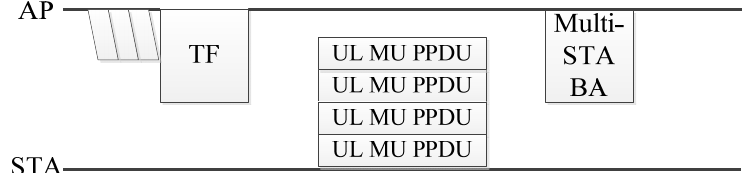
Figure 4. Uplink multiuser OFDMA procedure in accordance with IEEE 802.11ax. TF = trigger frame; Multi-STA BA = multi-station blockack; UL MU PPDU = uplink multi-user physical layer protocol data unit.